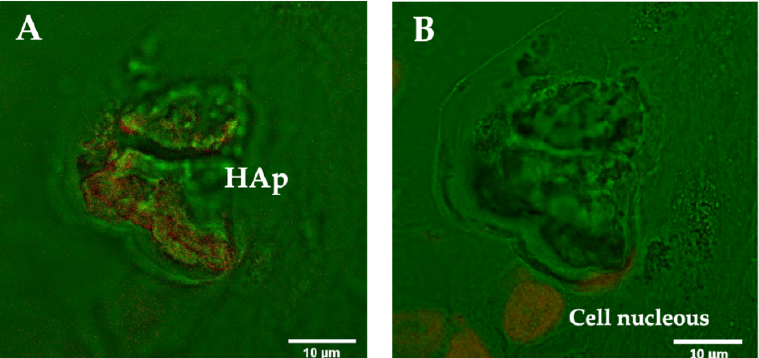
Figure 5. Confocal microscopy images of a breast cancer tissue section containing a HAp calcification at different depths: ( A ) image focused on the plane of the calcification, and ( B ) image focused on the plane of the surrounding cells in the tissue. DNA staining was performed with DAPI. Bright field (green) and DAPI (red). DAPI staining indicates the presence of DNA inside HAp calcifications and enables the visualization of the nucleus of the surrounding cells.